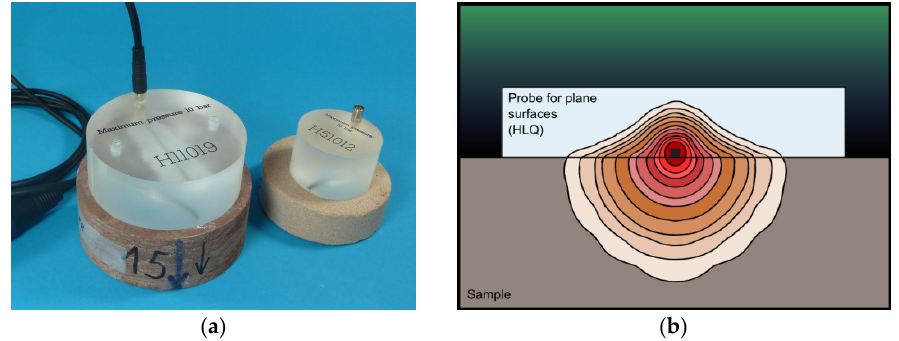
Figure 6. TeKa disk-shaped probe [44]. ( a ) TeKa disk-shaped material with embedded needle probe in the underside; ( b ) Heat profile in the disk-shaped material and sample, around the needle probe.